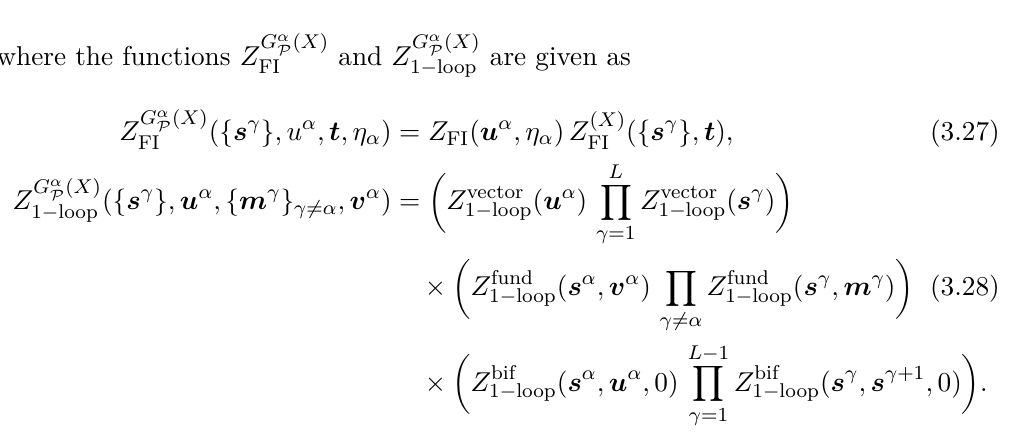
Figure 11 . This figure illustrates the gauging operation G α node U( M ) α